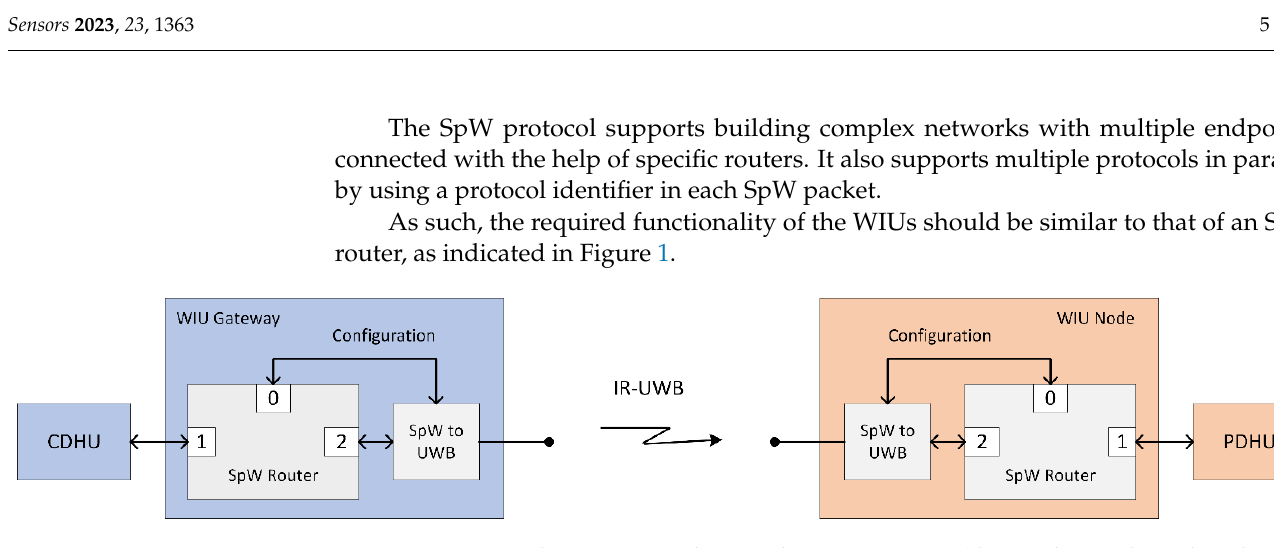
data over UWB between CDHU and PDHU simulators, as presented in Figure 2. Between means of an SpW Analyzer (i.e., STAR-Dundee SpW Link Analyser), which captures and displays bi-directional SpW traffic traveling over the link.